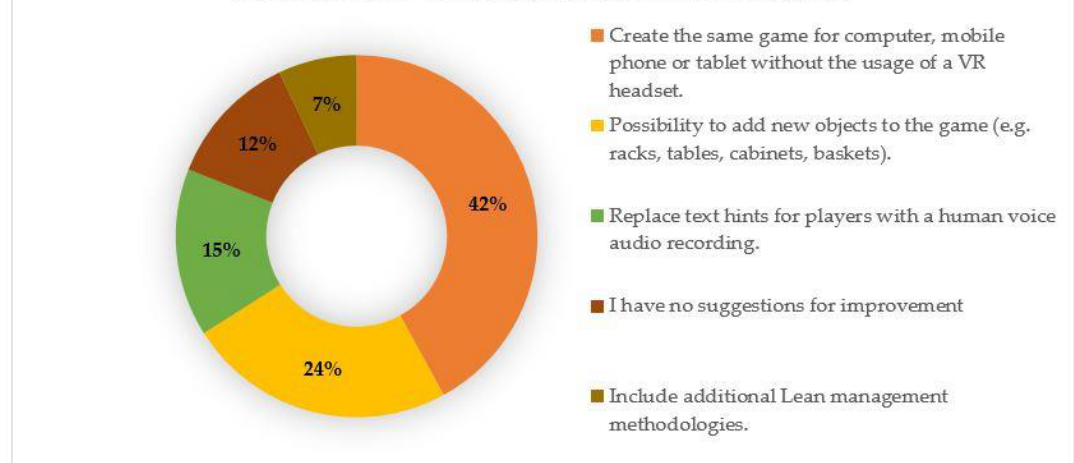
Figure 17. Recommendations for further development of the educational game.